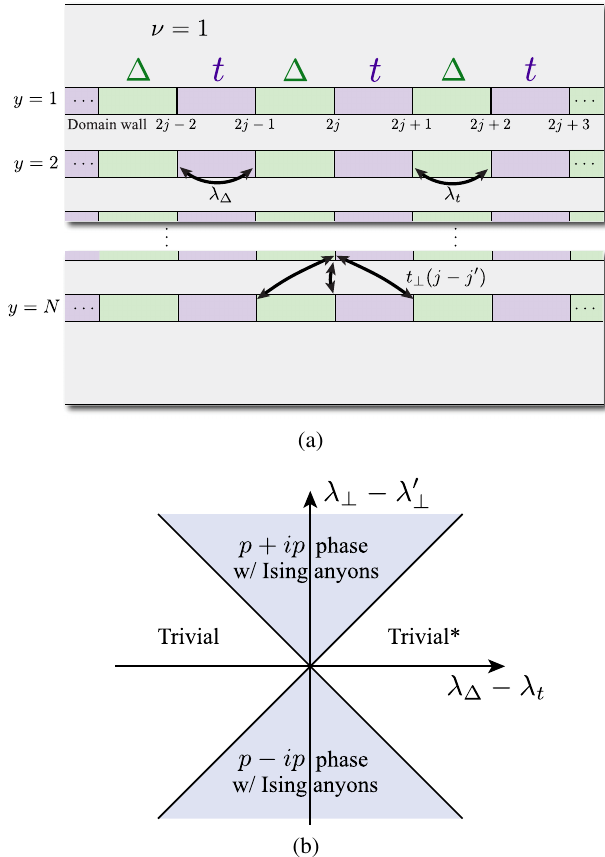
FIG. 3. (a) Variation on the setup of Fig. 2(a) that also supports a p þ ip superconducting state with Ising anyons. Here, a ν ¼ 1 quantum Hall system hosts spatially modulated trenches whose edge states are gapped in an alternating fashion by backscattering t and Cooper pairing Δ . When the trenches decouple and the gapped regions are “ large, ” each domain wall binds a Majorana zero mode. Electron hopping across the domains hybridizes the chain of Majorana modes in each trench through couplings λ Δ and λ t shown above. These couplings favor competing gapped phases, and when λ Δ ¼ λ t , each chain realizes a critical point with counterpropagating gapless Majorana modes in the bulk — similar to the uniform-trench setup of Fig. 2(a). Turning on weak coupling t ⊥ ð j − j 0 Þ between domain walls j and j 0 in adjacent trenches then generically drives the system into a p þ ip phase (or a p − ip state with opposite chirality). (b) Phase diagram for the 2D array of coupled Majorana modes near criticality. Here, λ ⊥ and λ 0 ⊥ represent interchain couplings between gapless Majorana fermions at the critical point, which follow from t ⊥ ð j − j 0 Þ according to Eq.